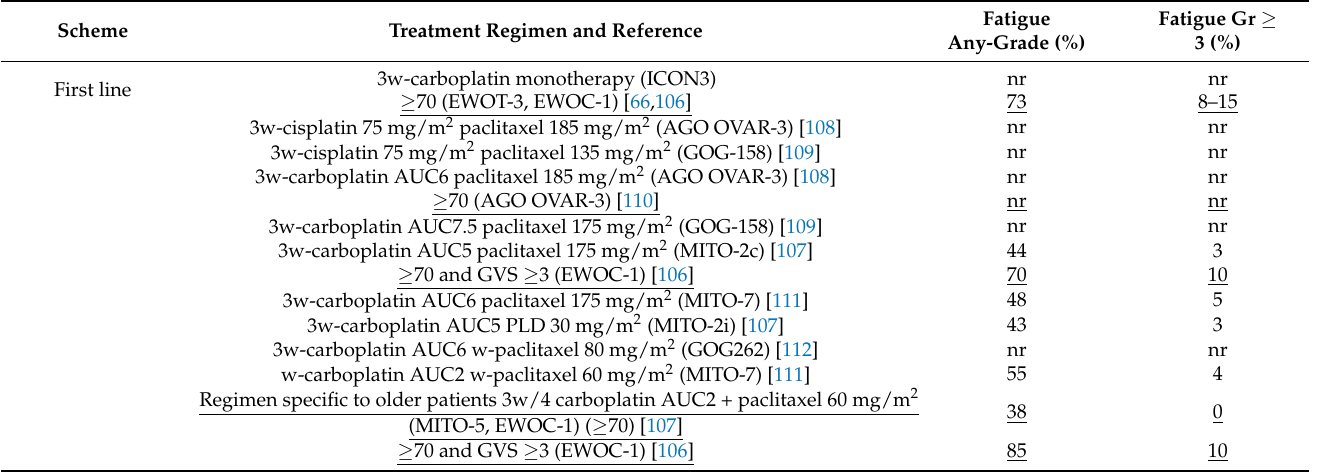
Table 2. Fatigue events in the most common anticancer regimens for ovarian cancer. Abbreviations: AUC: area under the curve; ctrl: control; nr: not reported; PLD: pegylated liposomal doxorubicin. Treatment Regimen and